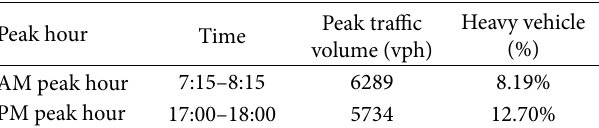
Table 1: Number of vehicles and heavy vehicle percentage in peak